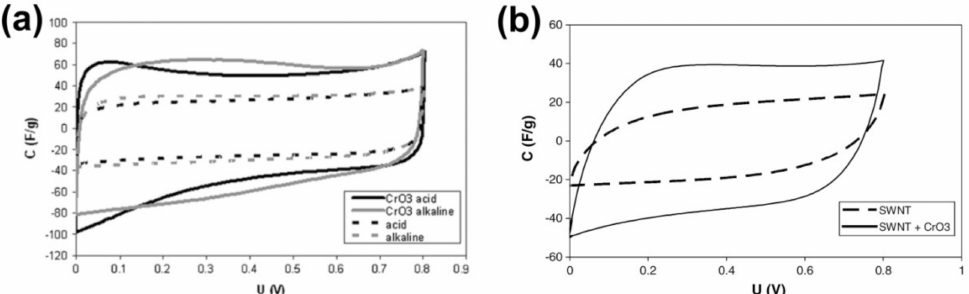
Figure 7. ( a ) Cylic voltammograms at 20 mV s − 1 for CrO 3 − filled SWCNT (solid lines) and empty SWCNT (dotted lines) as electrode materials in alkaline (gray lines) and acidic (dark lines) electrolytes. ( b ) Capacitance calculated from voltammetry experiments for CrO 3 − filled SWCNT (solid lines) and empty SWCNT (dotted lines) in acidic electrolytes. Reprinted from [196] with permission from